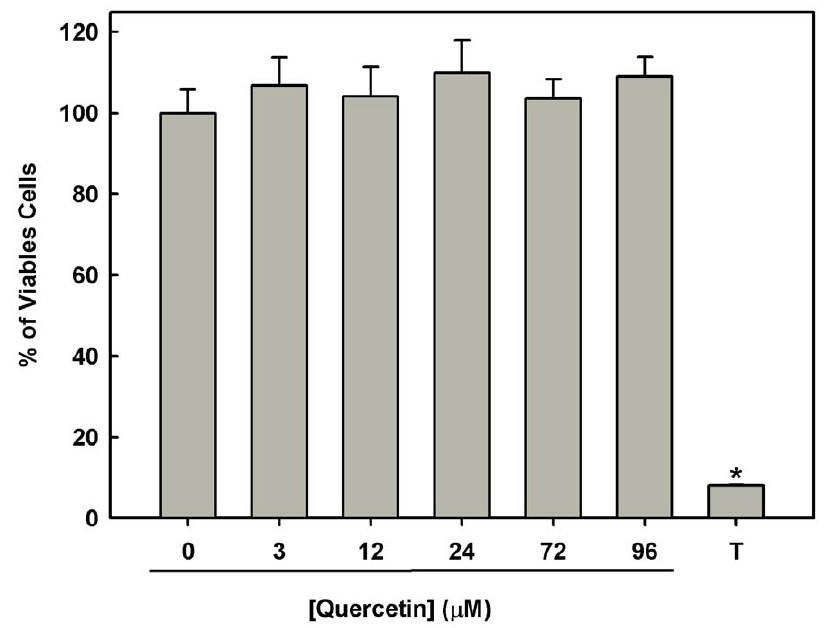
Figure 4. Comparison of the L.amazonensis untreated and treated with different concentration of quercetin. Leishmania amazonensis was cultivated in Schneider’s Drosophila medium at 26 u C as for 48 h in the absence or presence of different concentration of quercetin (3 m M– 96 m M). Cellular viability was measured using Alamar Blue assay as described under Material and Methods. Values shown are the mean 6 standard error of three different experiments. In the control (absence of quercetin), the same volume of vehicle (DMSO 0.2%) was added to the growth medium. Positive control (disrupted cells) was obtained by addition of 0.1% of Triton X-100 * indicates significant difference relative to the control group ( p , 0.05). T 2 0.1% Triton X-100.